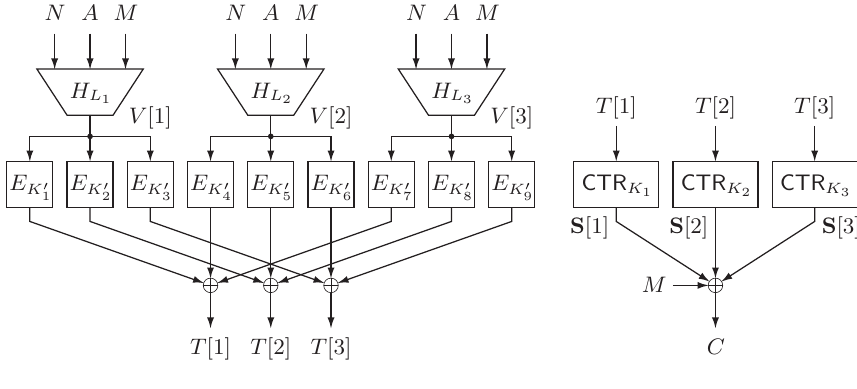
Figure 7: The encryption algorithm of GCM-SIV r for r =